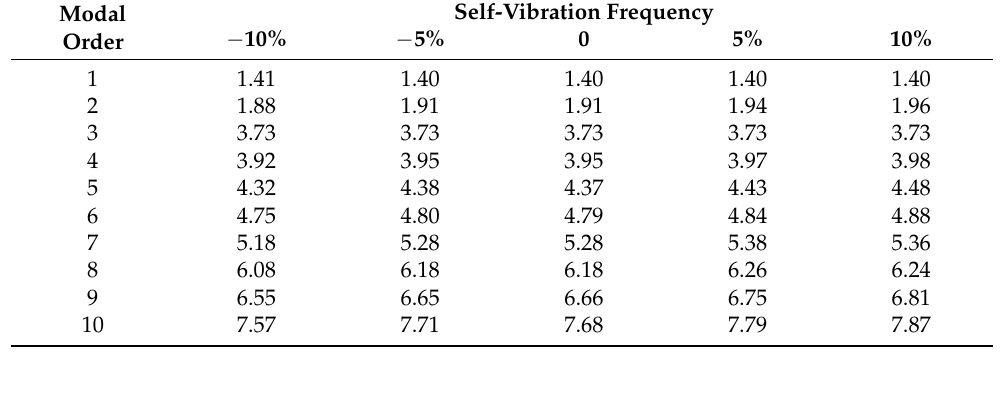
Table 4. Self-vibration frequencies (Hz) for different main beam stiffnesses of the original structure. Modal Order